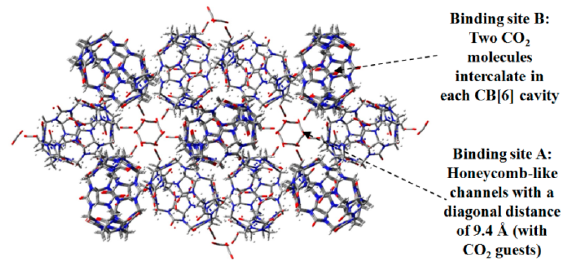
Figure 14. X-ray diffraction geometry of crystalline porous H13 with CO 2 as guest.